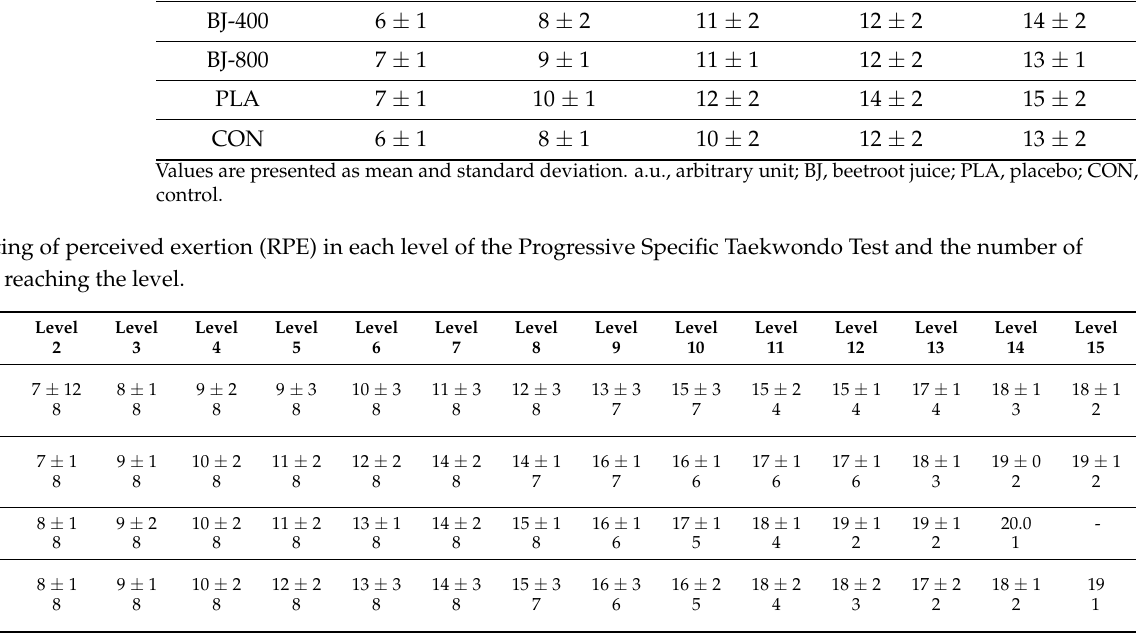
Table 3. Rating of perceived exertion after each set of the Frequency of Speed Kick Test. Set 1 (a.u.)